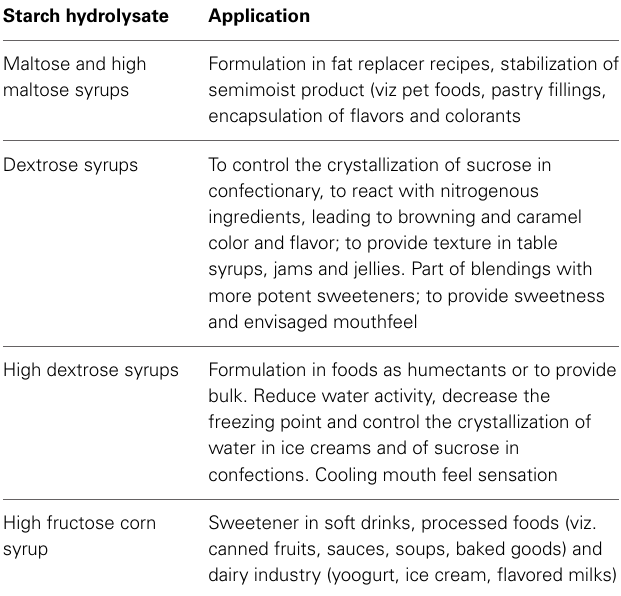
Table 3 | Examples of applications of starch hydrolysates in the food sector (Blanchard and Katz, 2006; Parker et al., 2010; Dar,